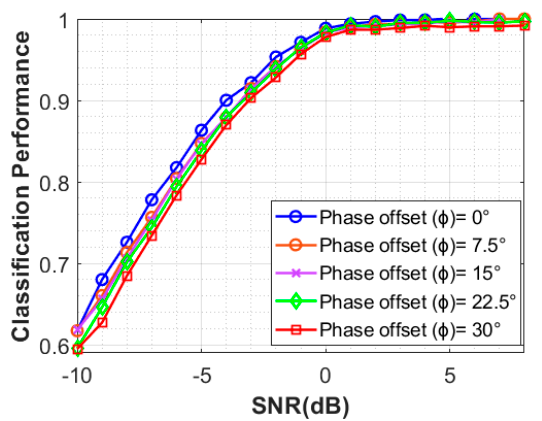
Information 2019 , 10 , x FOR PEER REVIEW Figure 11. Performance of NSVM with different Phase Offsets. Figure 11. Performance of NSVM with di ff erent Phase O ff sets.